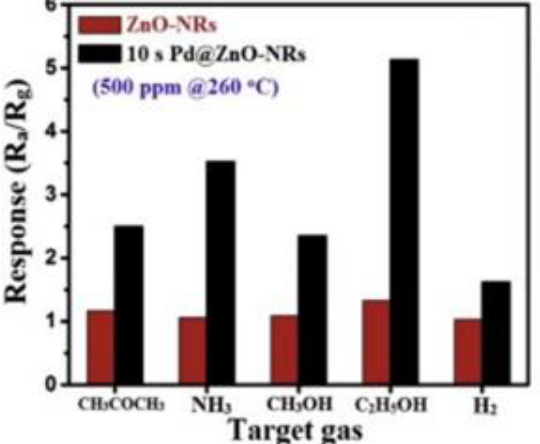
Figure 4. The selectivity of ZnO and Pd@ZnO nanorod sensors at 500 ppm concentrations of different types of gases. [122]. Reproduced (2020) with permission from Elsevier.